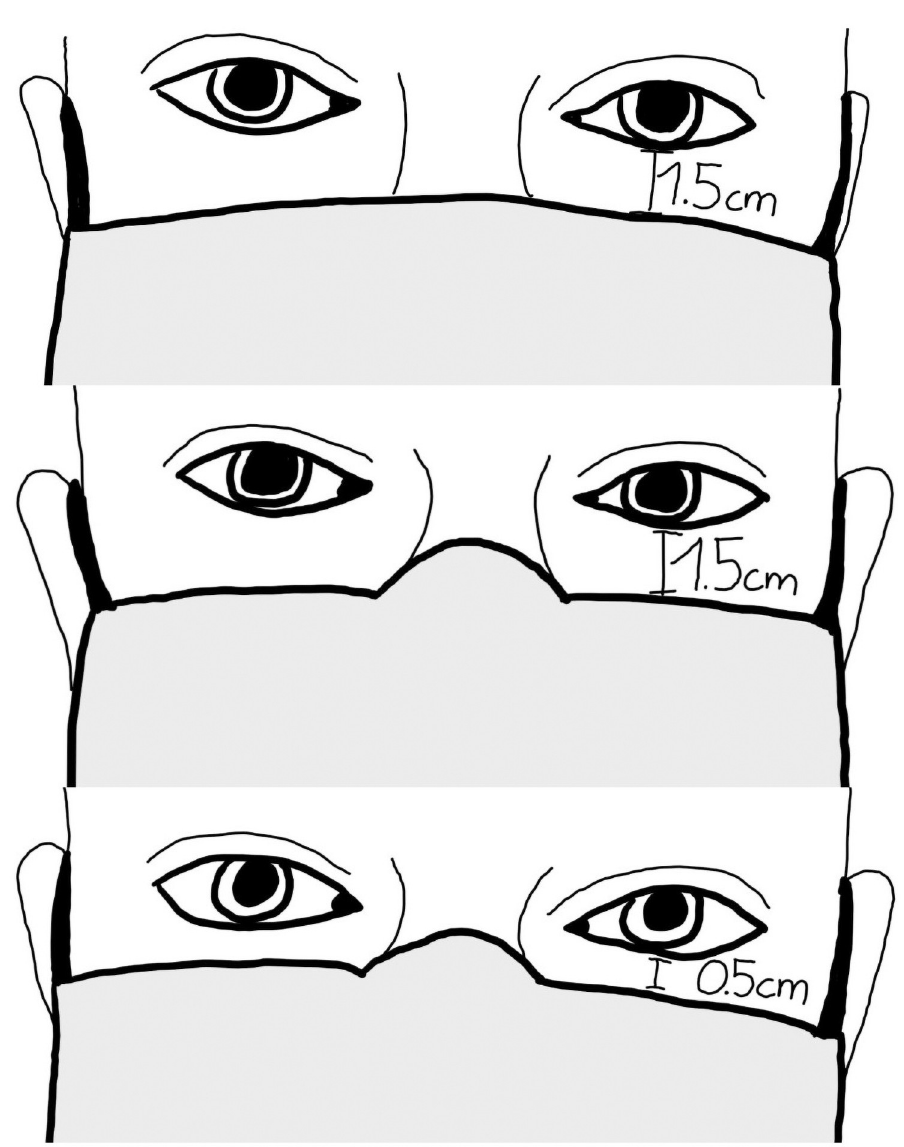
Fig 1. Position of the mouth-nose mask during visual field testing. Position 1.5cm_no_clip (top): 1.5 cm below the lower eyelid without using the nose clip; position 1.5cm_with_clip (middle): 1.5 cm below the lower eyelid with use the nose clip; position 0.5cm_with_clip (bottom): 0.5 cm below the lower eyelid using the nose clip.